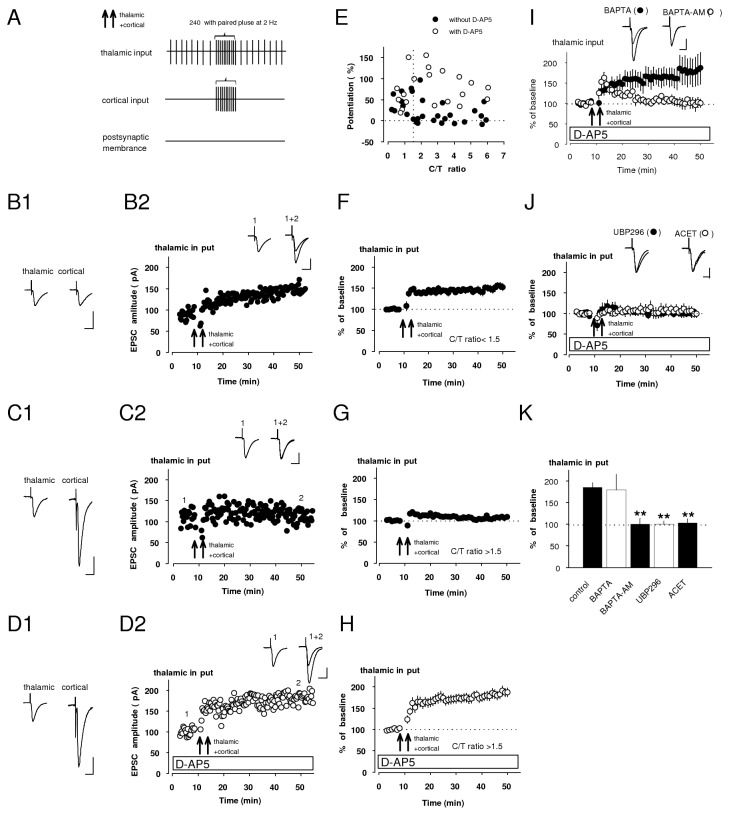
Pre-LTP in thalamic input depends on synaptic activity at cortico-LA synapses.
A, Schematic representation of the induction protocol used in this experiment. Double arrows indicate the induction protocols consisting of paired stimulation of both thalamic and cortical inputs without postsynaptic depolarization. B, C, An individual experiment (B2, C2) investigating whether LTP could be induced or not by the induction when the amplitude of cortical EPSC is smaller (B1) or larger (C1) than that of thalamic. D, An individual LTP experiment (D2) showing effect of D-AP5 on the non-potentiated EPSC (C2). Insets (B1-D1): EPSCs in both thalamic and cortical inputs before the induction. Insets (B2-D2): averaged EPSCs before (1) and after (2) delivery of the induction (double arrows). Scale bar (B-D) 50 pA, 20 ms. E, Relationship between C/T ratio (before the induction) and the magnitude of LTP in thalamic input induced the induction with (open circles) or without D-AP5 (closed circles) in the bath solution. Each symbol represents a separate experiment. F-H, Summary graphs of LTP experiments (B-D) EPSCs observed with C/T in a range below 1.5 resulted in robust potentiation (F: 152 ± 8% of baseline, n=10, paired t test, p<0.01 versus baseline). When the data were collected in a range of C/T > 1.5, lesser LTP was observed (G, 110 ± 4% of baseline, n=19, paired t test, p=0.045 versus baseline). In the same range of C/T, the EPSCs were significantly potentiated by addition of D-AP5 (H, 185 ± 11% of baseline, n=13, paired t test, p<0.01 versus baseline). I, This observed potentiation was resistant to BAPTA (20 mM) (180 ± 36% of baseline, n=6, p=0.85 versus control by unpaired t test), but was blocked by BAPTA-AM (50 µM) (100 ± 13% of baseline, n=5, p<0.01 versus control by unpaired t test). J, LTPct was completely blocked by either UBP296 (1 µM) (100 ± 7% of baseline, n=4, p<0.01 versus control by unpaired t test) or ACET (0.5 µM) (103 ± 10% of baseline, n=5, p<0.01 versus control by unpaired t test). Insets: superimposed averaged EPSCs recorded before and after the induction with application of each drug. Scale bars: 50 pA, 20 ms. K, Quantification of pharmacological experiment results (H, I, J). Control was obtained from the result in Figure 4H
. **p<0.01; unpaired t test.